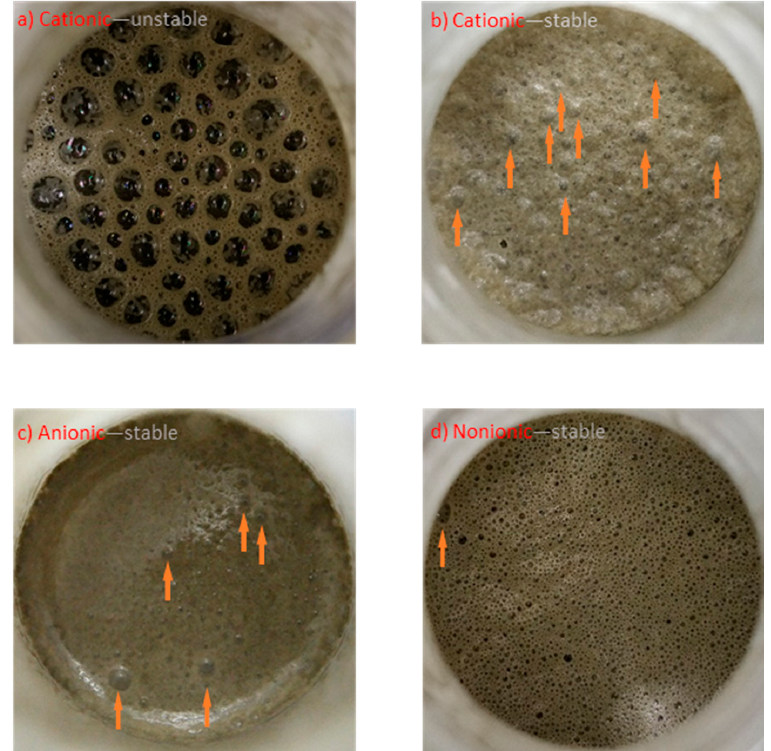
Figure 6. Pictures of foam layers in foam index tests without fly ash. ( a ) Unstable foam of the cationic surfactant; ( b ) stable foam of the cationic surfactant; ( c ) stable foam of the anionic surfactant; ( d ) stable foam of the nonionic surfactant. Arrows show the position of large air bubbles when the endpoint is reached.